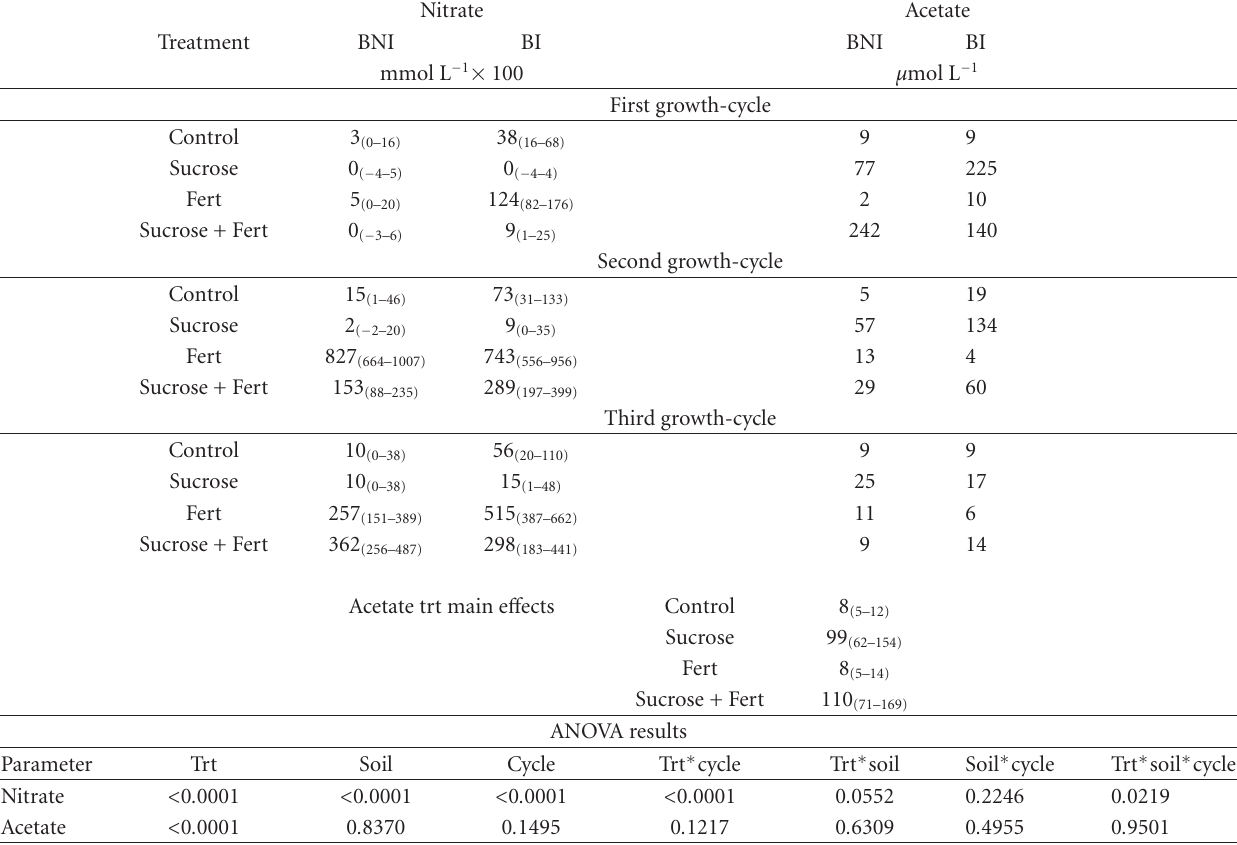
Table 4: Influence of treatment, soil invasion status, and growth-cycle on soil-solution nitrate and